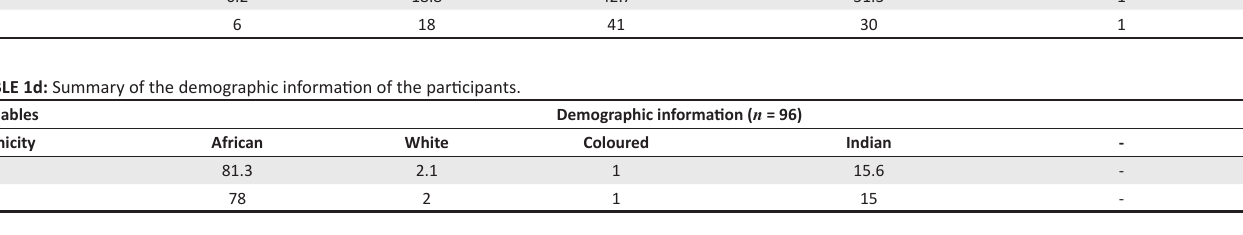
TABLE 1e: Summary of the demographic information of the participants.